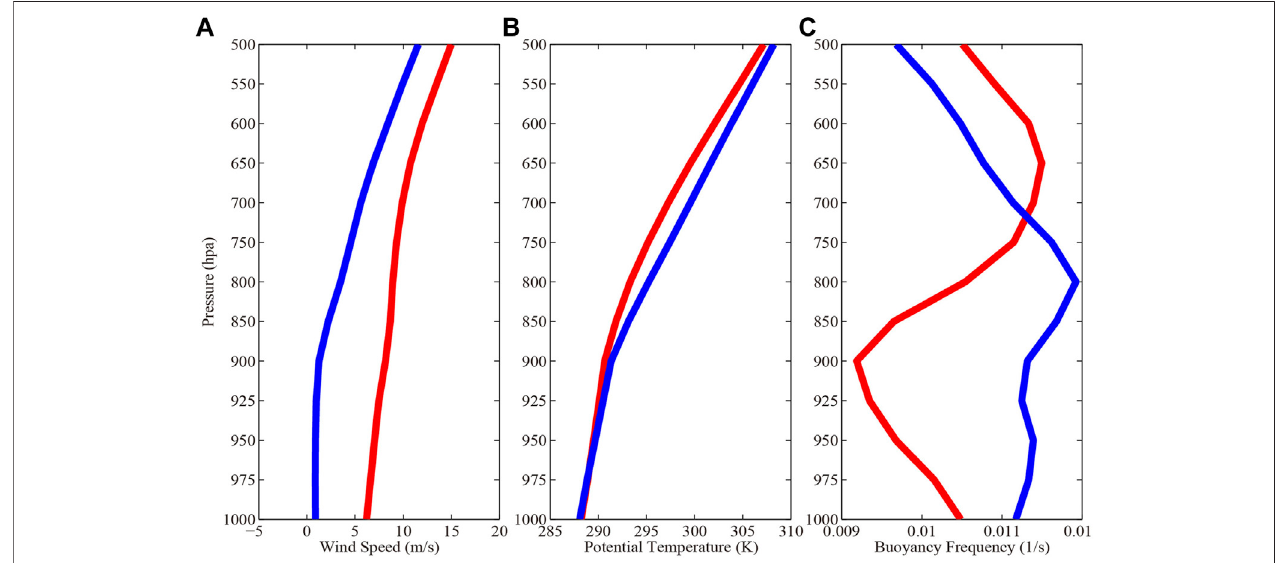
FIGURE 13 | Vertical pro fi les of (A) horizontal wind speed, (B) potential temperature, and (C) buoyancy frequency in the upstream region of the Tianshan Grand Canyon (TGC). Red lines are for the case of High_Wind while blue lines are for Low_Wind. These pro fi les are obtained by areal average within a 1 ° × 1 ° box centered at point C in Figure 11